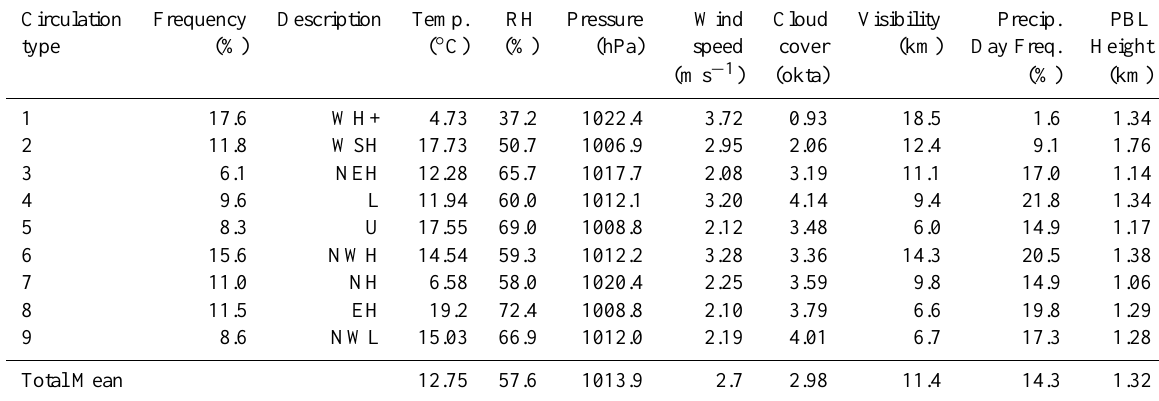
Table 1. Means of local (BCIA) meteorological variables classified by circulation types during the 2000–2009 period. The daily maximum PBL height was calculated from the WRF model for 1yr (June 2008 – May 2009).